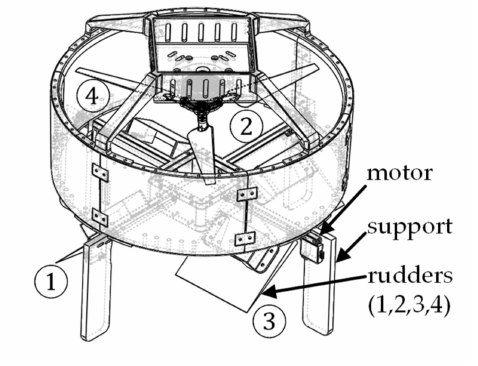
Figure 3. Schematic of the rudders and actuators and their corresponding